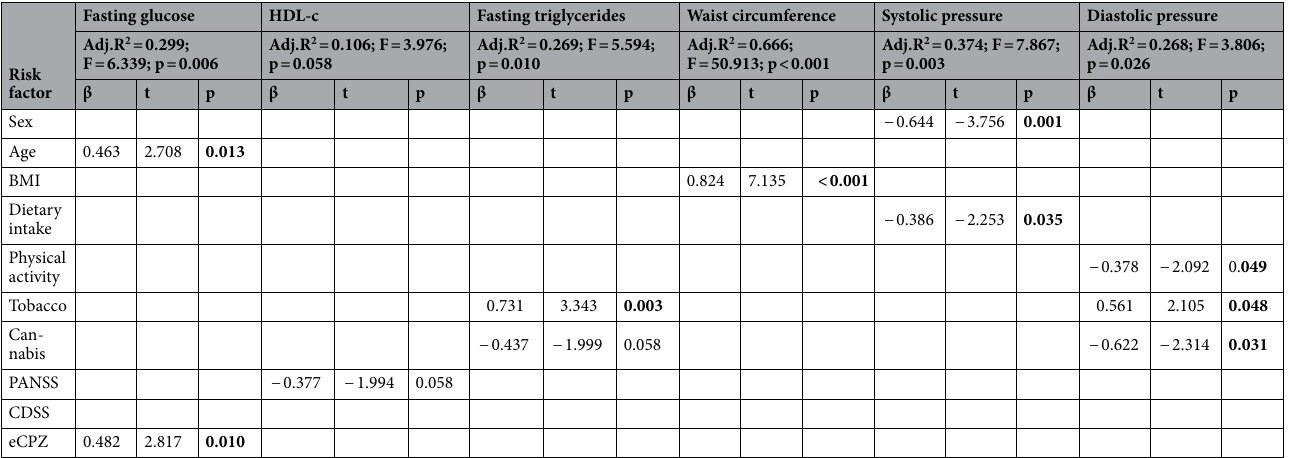
Table 3. Linear model for predicting metabolic parameters in patients with ROP at baseline. ROP recent-onset psychosis, Physical activity metabolic equivalents of task (MET)-min/week, Dietary intake Kcal/day, Tobacco daily consumption or not, Cannabis daily consumption or not, PANSS positive and negative syndrome scale, total score, CDSS Calgary depression scale for schizophrenia, eCPZ equivalent doses of chlorpromazine/day. Significant p values are shown in